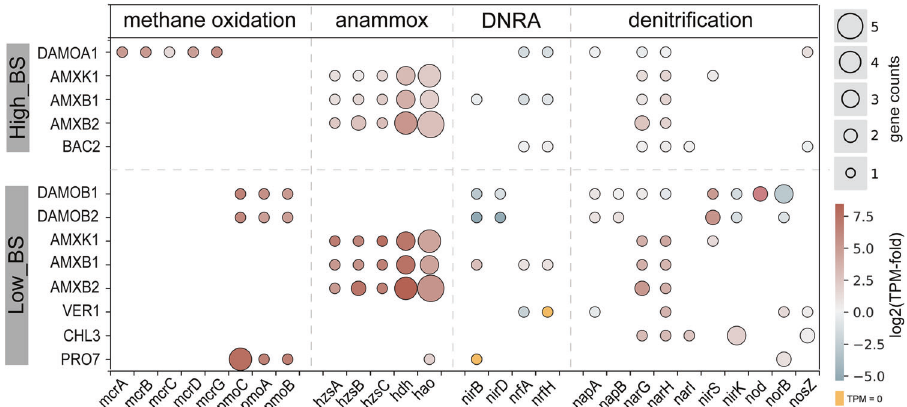
Fig. 3 Relative expression of genes involved in major methane and nitrogen metabolic pathways encoded by each MAG. Colour intensity represents gene expression. Gene expression was relativized by median TPM value across all CDS within a given genome (see details in Methods). A value of one means two times of median expression among all CDS in a given genome. Orange cell indicates the expression of the encoded gene is undetectable. Bubble diameter represents the gene count. Only the MAGs with expression >1% were presented. The TPM values of encoded genes by each MAG were listed in Supplementary Dataset